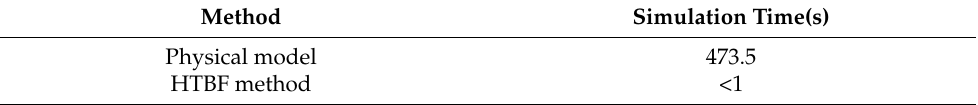
Table 1. Comparison between the physical model method and the HTBF method.